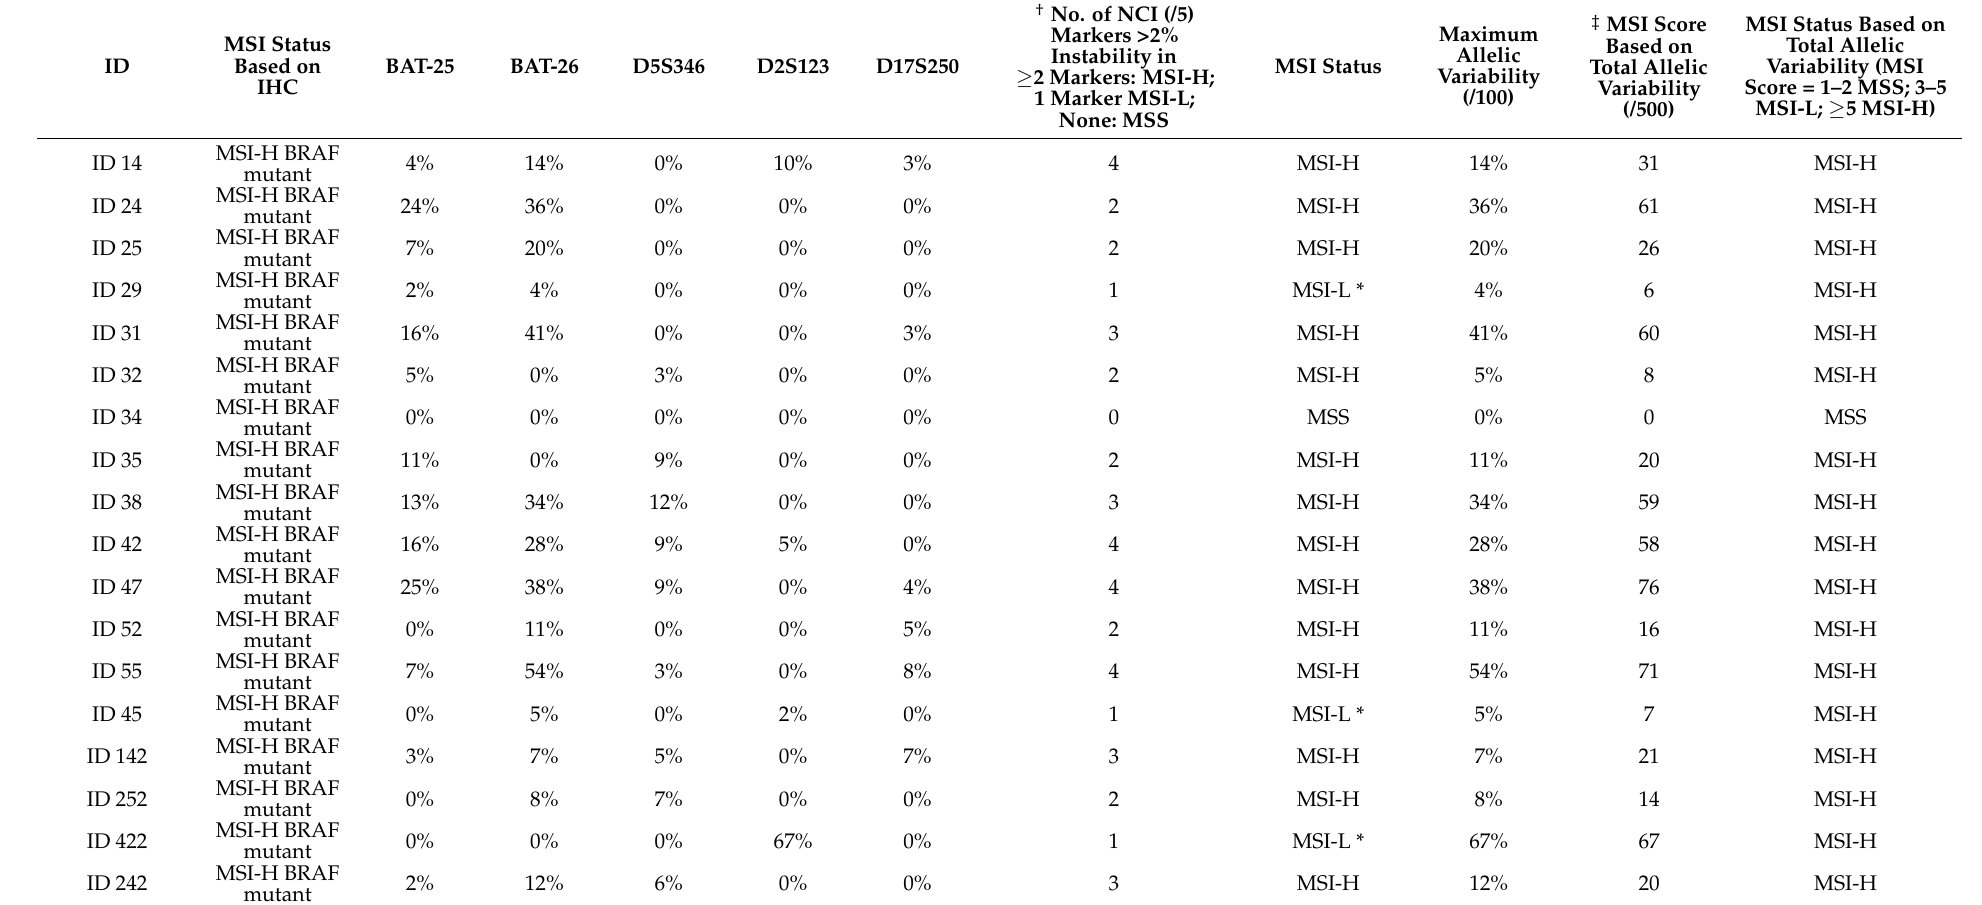
Table 5. Correlation between MSI status detection using high-resolution capillary electrophoresis with (a) traditional analysis and (b) MSI score based on total allelic variability, compared to immunohistochemistry (IHC) for MSI-H BRAF mutant tumours from patient